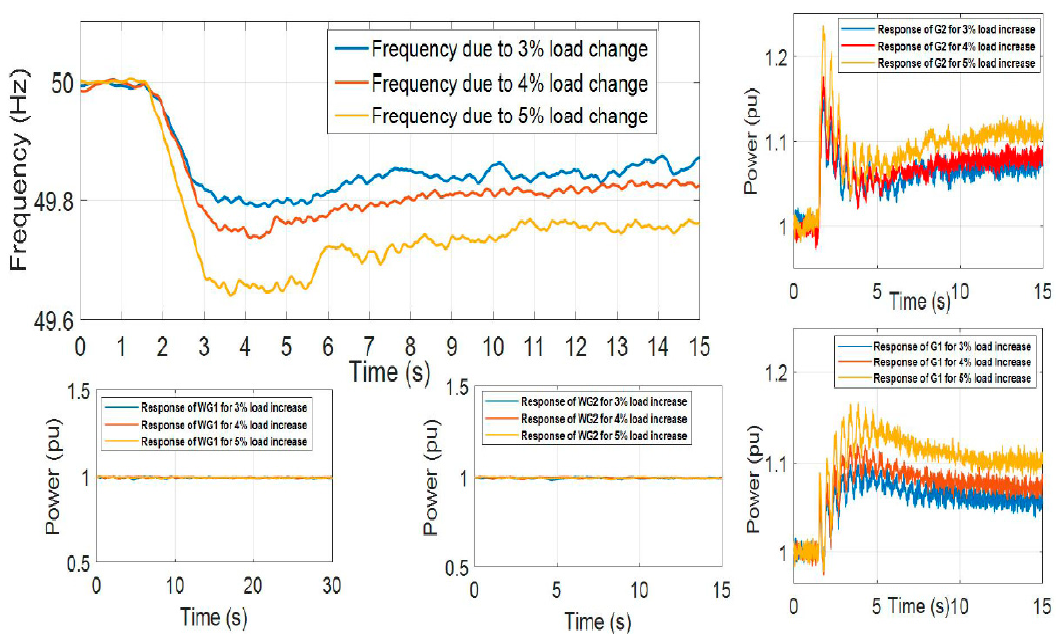
Figure 10. EMT simulations performed in RTDS (i.e., without FAPR, no use of PHIL). Response of wind and synchronous generators and their impact on frequency dynamics.